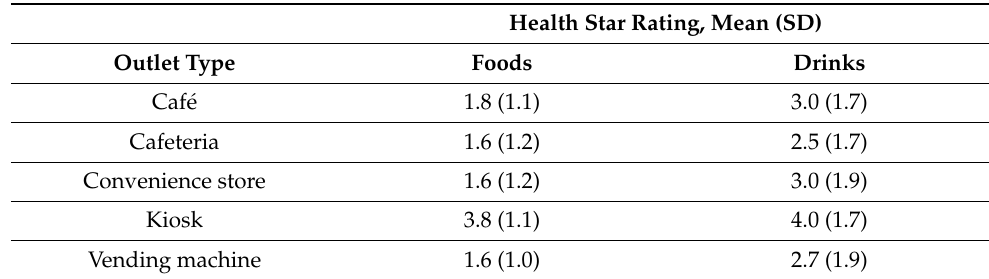
Table 5. The mean (SD) Health Star Rating across food and drinks available for sale, by outlet type. Health Star Rating, Mean